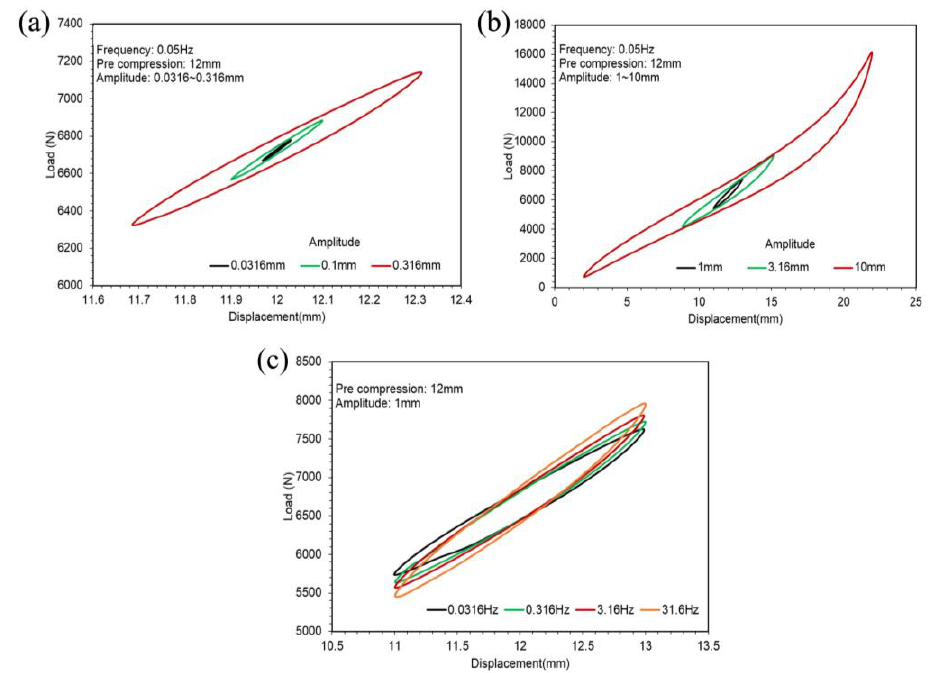
Figure 9. Hysteresis loops of the SCCT rubber spring.